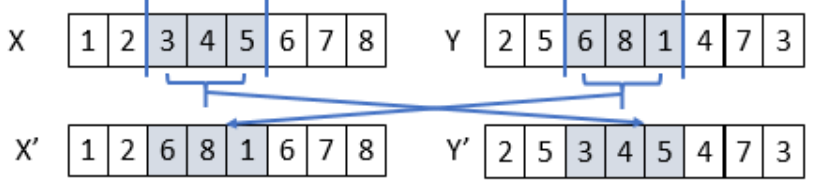
Figure 2. Example of